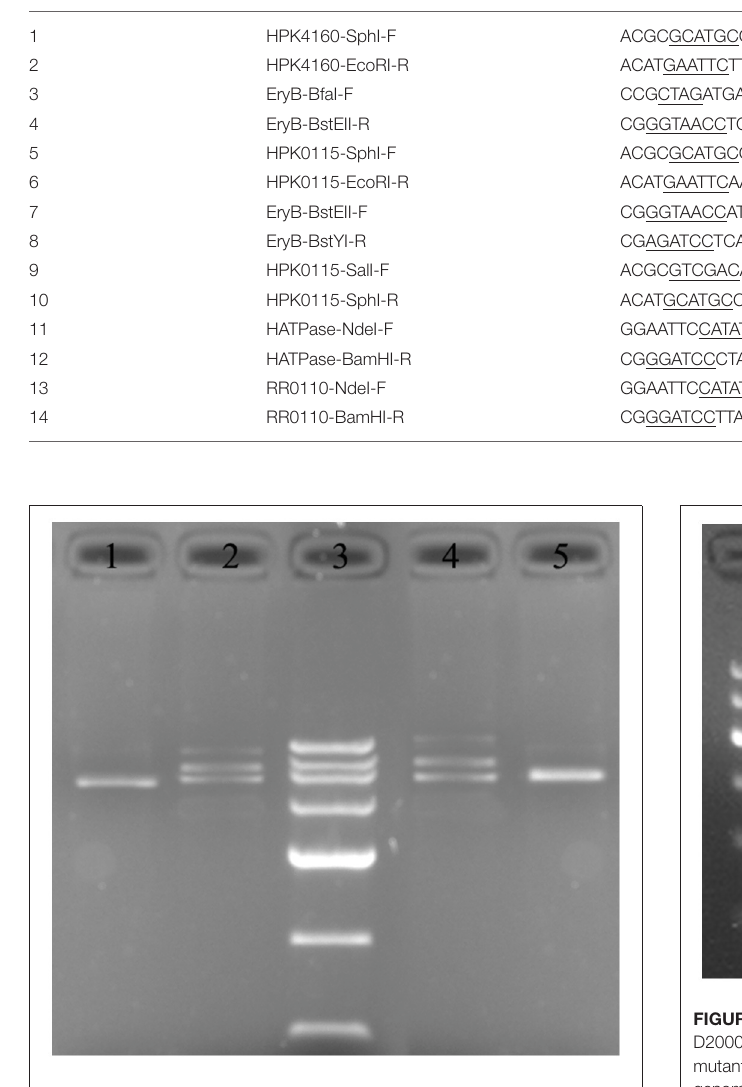
FIGURE 6 | Recombinant plasmid mapping. 1: PCR detection of the HPK4160::EryBII gene from pUC19-HPK4160::EryBII using Primers 1 and 2;